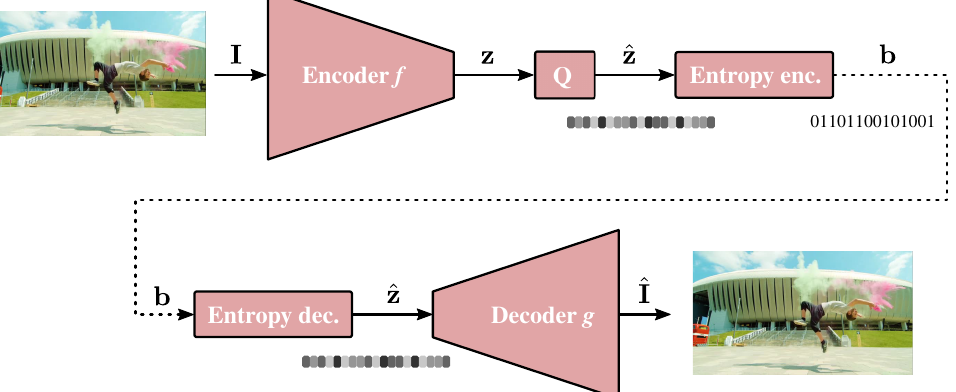
Figure 3. Usual architecture of end-to-end learning-based compression algorithms. The encoding and decoding functions f and g enables us to project the multimedia signal into a latent space of reduced dimension. The quantization Q and the entropy coding aims at describing the latent vector into a compact binary